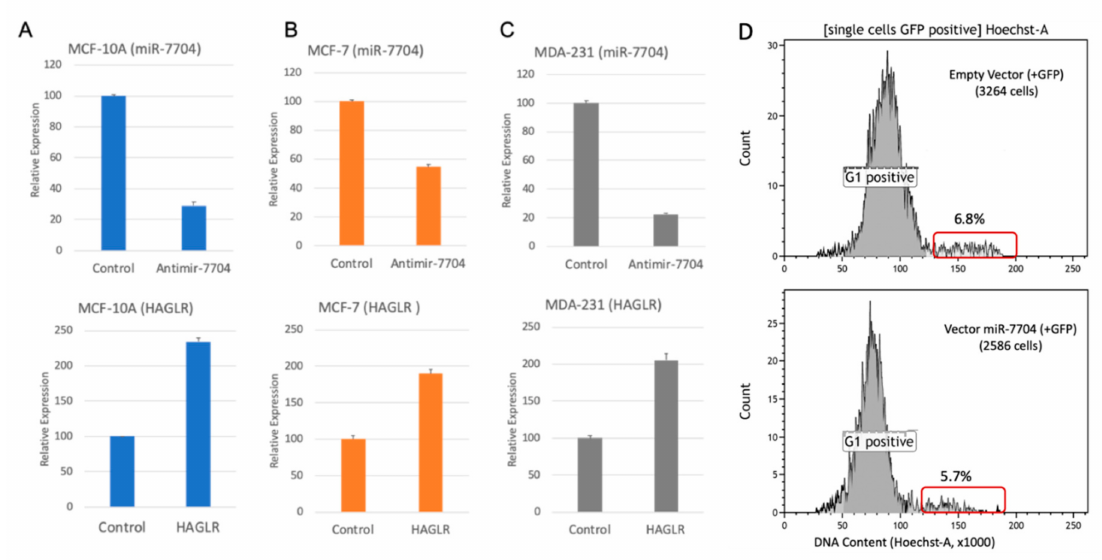
Figure 6. Manipulating SF-miR-7704 levels. ( A – C ) Inhibition of miR-7704 expression upregulates the expression of HAGLR. Results of quantitative real time PCR analysis of the e ff ect of the inhibition of miR-7704 on the nuclear expression of HAGLR in MCF-10A ( A ), MCF-7 ( B ), and MDA-MB-231 cells ( C ) are shown. Transfection with Anti-miR-7704 inhibitor resulted in the down-regulation of miR-7704 (upper panel), and an increase in the expression level of HAGLR mRNA (lower panel) relative to the control. For the control we used the non-silencing Anti-miR (see Materials and Methods). The average of 3 independent biological preparations are shown, including the standard error. The expression levels of HAGLR was normalized to the internal control of ß-actin expression from the same